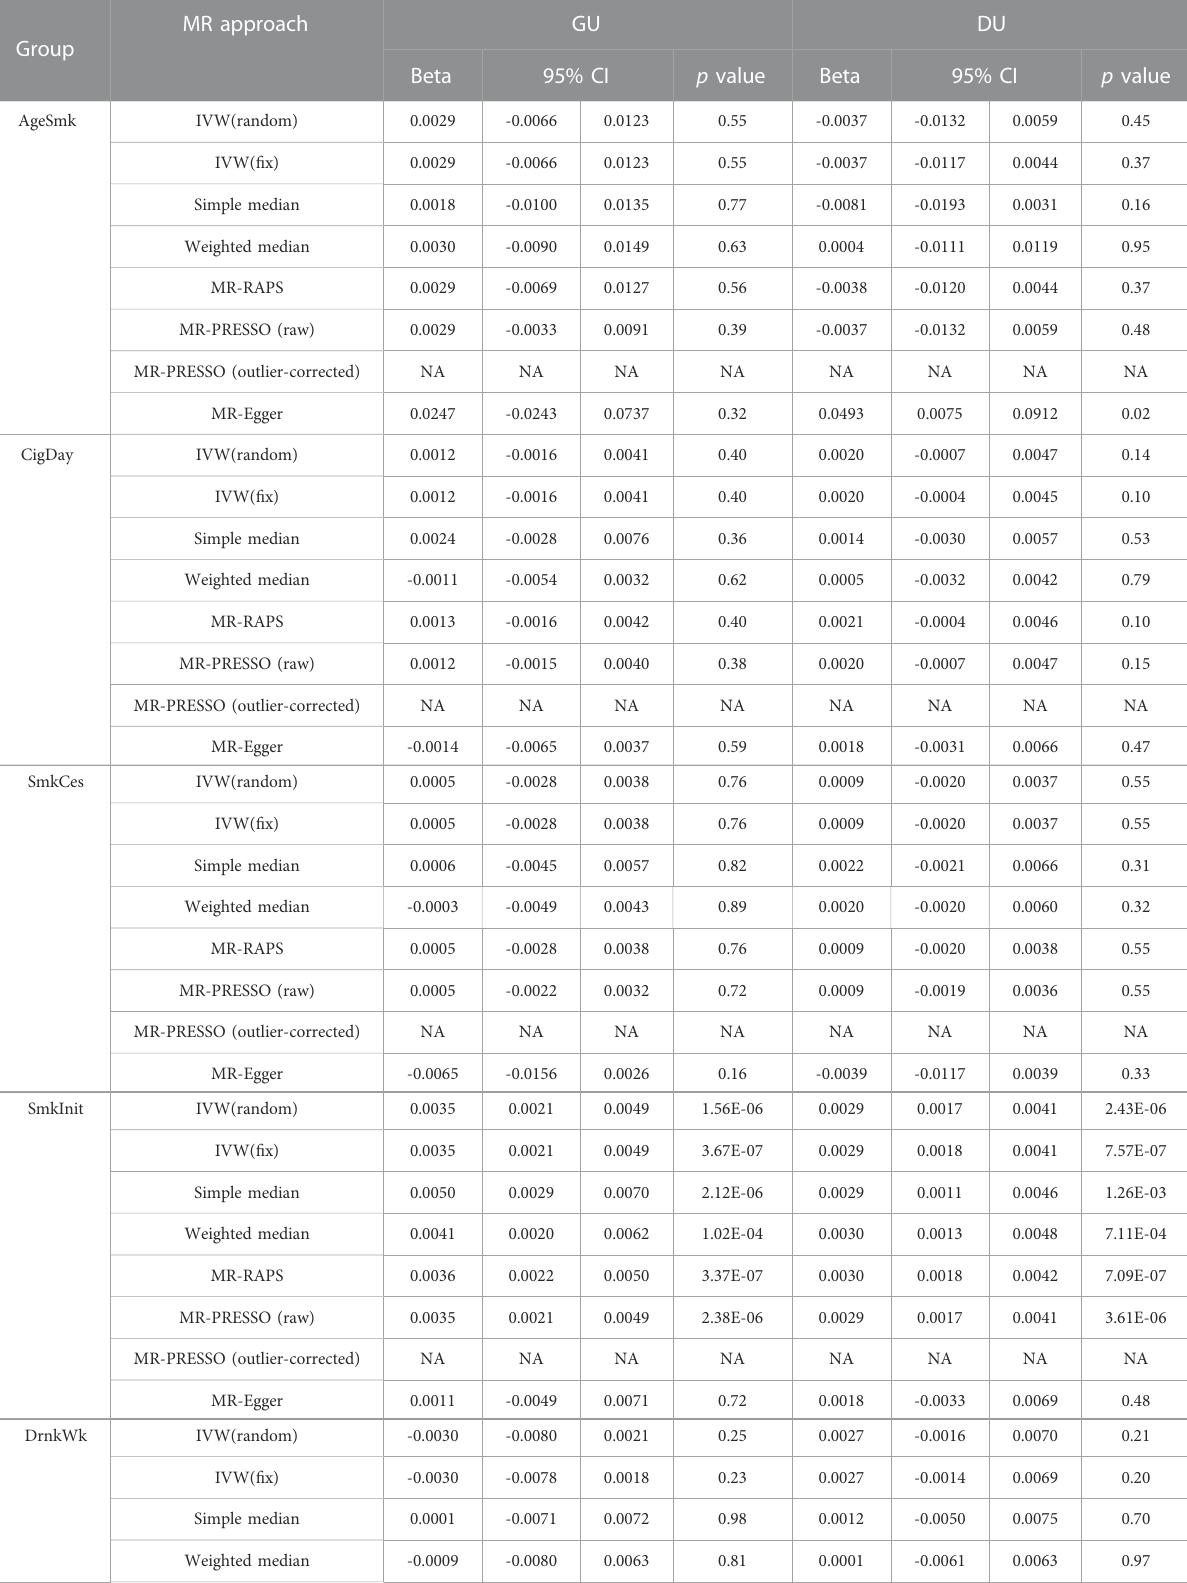
TABLE 1 Summarized results of the Mendelian randomization study on smoking, alcohol consumption, diabetes, and BMI and GU and DU risks.